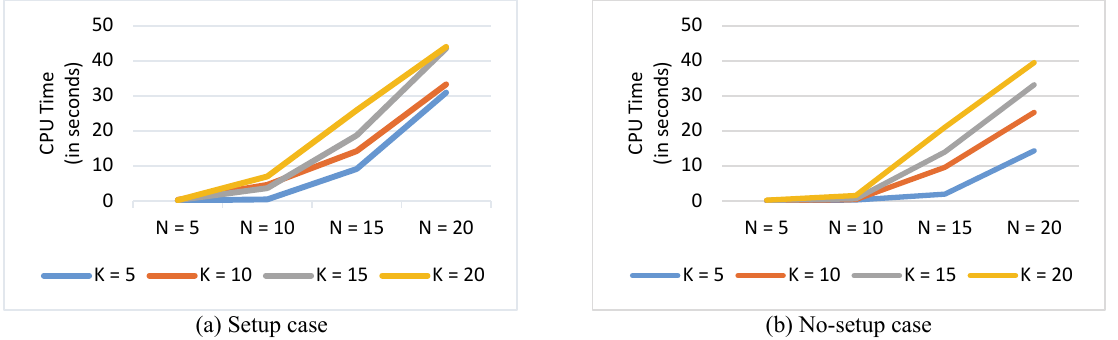
(a) Setup case (b) No-setup case Fig. 3. Average CPU time of the heuristic